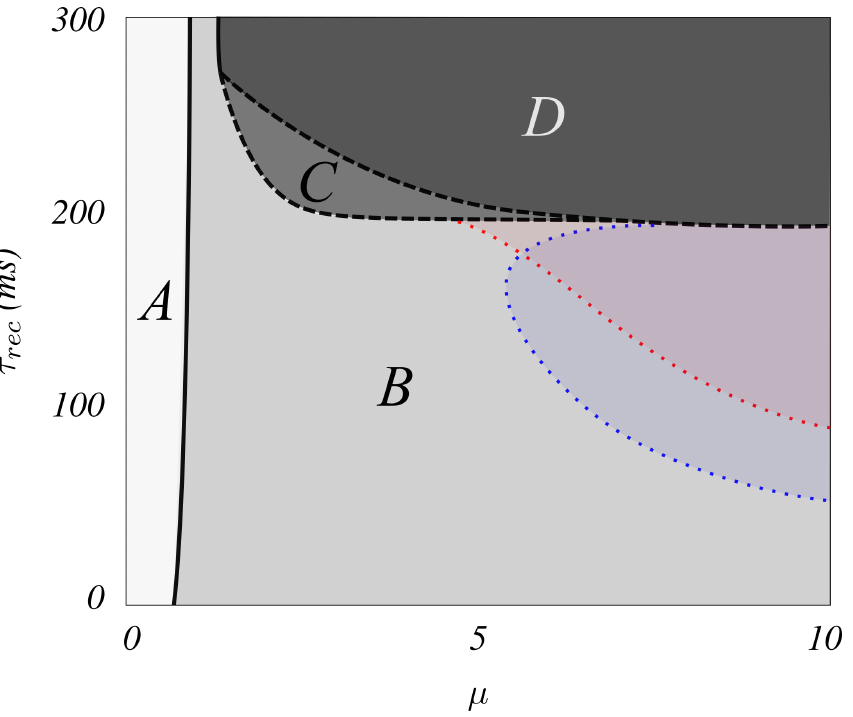
Figure 3. Diagram ( µ , τ rec ) illustrating the different dynamical phases in our system. For low noise (region A), random sporadic excitatory firing events emerge, which are unable to depolarize the I neurons. Region B shows well-defined rhythms ranging from α to γ bands, while a higher depression induces a cease of the inhibitory activity and a consequent absence of synchronicity and coherence in region D. Metastability, as illustrated in Figure 2, characterizes the region C. Red and blue colored areas in B indicate emerging waves with high values of the firing rates (>100 Hz) for E and I neurons, respectively. Dashed lines illustrate first-order phase transitions, while continuous lines denote second-order